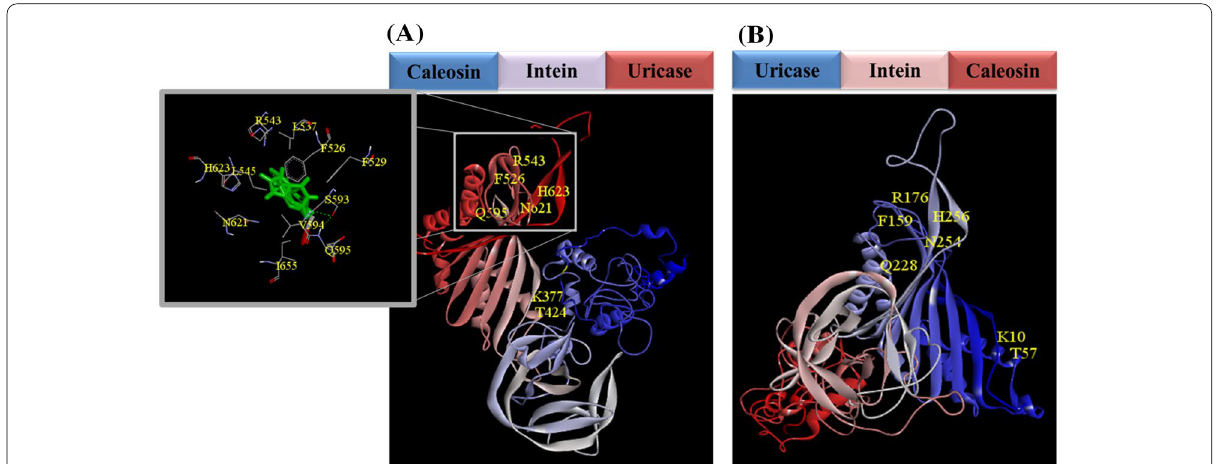
Fig. 6 The predicted structure for A CU and B UC chimaeras by Phyre2. The domain arrangements with the corresponding colours are shown on top of the shapes. The docking complex between CU chimaera and uric acid is also